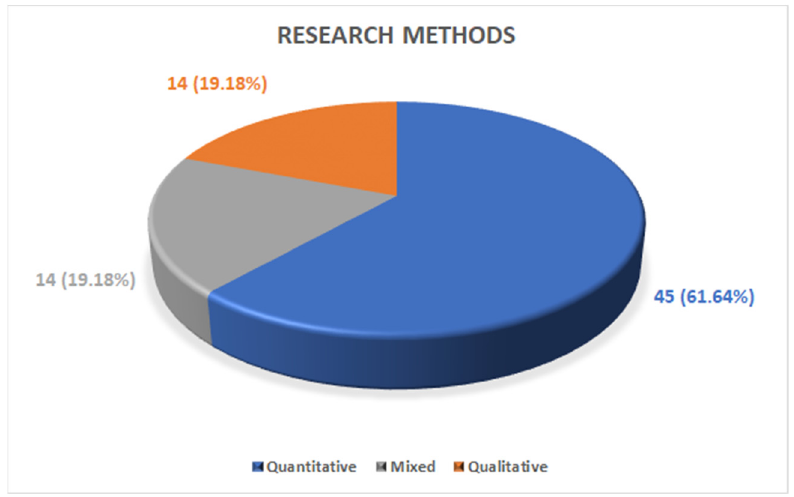
Figure 5. Empirical studies: research methods.